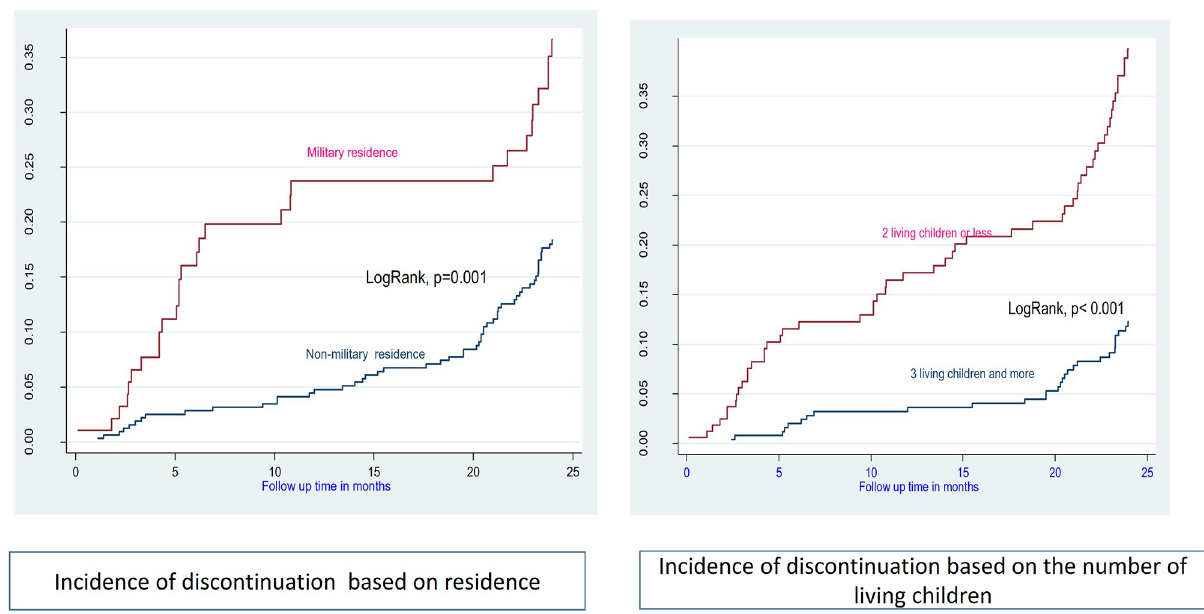
Fig 2. Incidence of discontinuation based on residence and